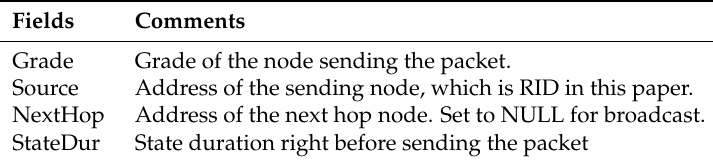
Figure 1. Data transmission process in D3 with the CW2-RTS/CTS handshake; node S sends data to the sink node. Table 1. Frame Format of RTS/CTS